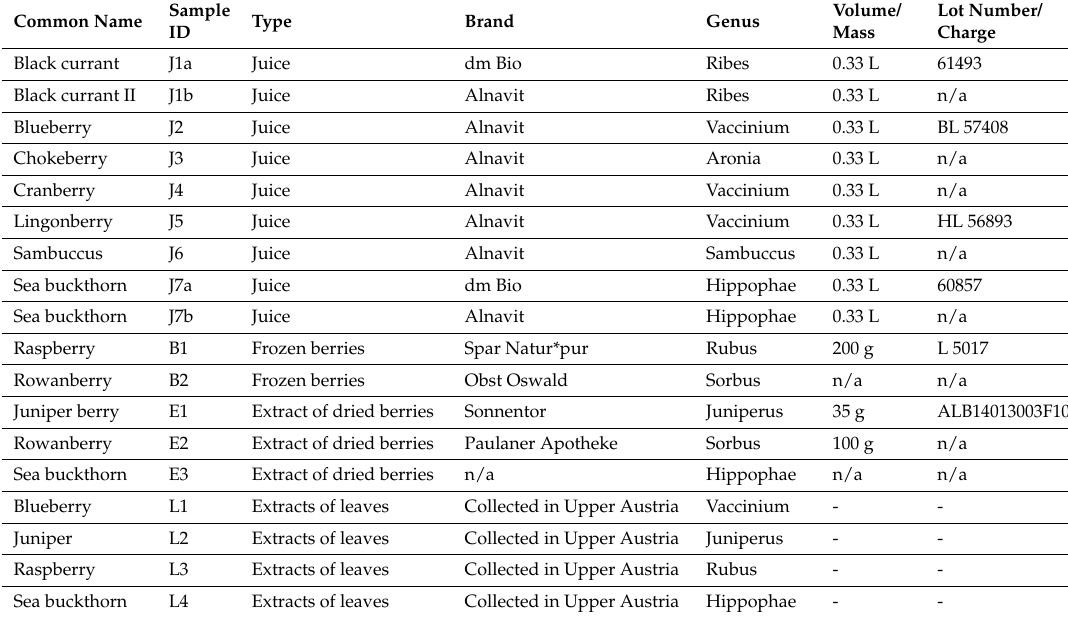
Table 1. An overview of all 18 examined